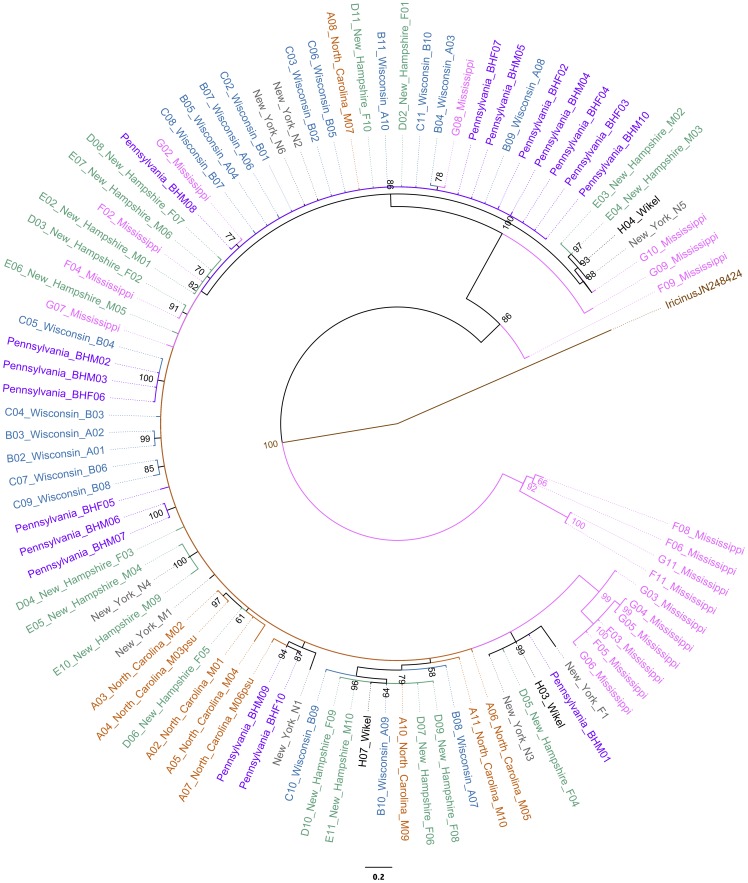

I. scapularis COI Bayesian phylogeny.The tree was rooted to Ixodes ricinus ( =  Brown, GenBank JN248424). Pink  =  Mississippi; blue  =  Wisconsin; orange  =  North Carolina; green  =  New Hampshire; purple  =  Pennsylvania; gray  =  New York; and black  =  Wikel Colony. Numbers at nodes represent posterior probability values and branch length corresponds to number of substitutions.